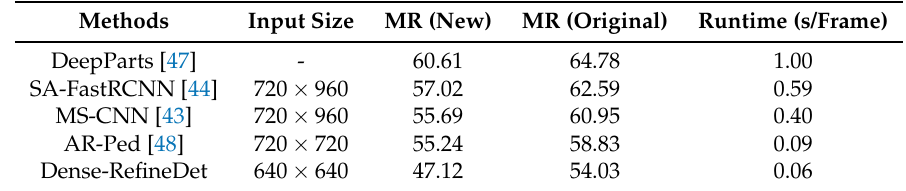
Table 2. The computational efficiency comparison of Dense-RefineDet with other methods on the Caltech pedestrian dataset.